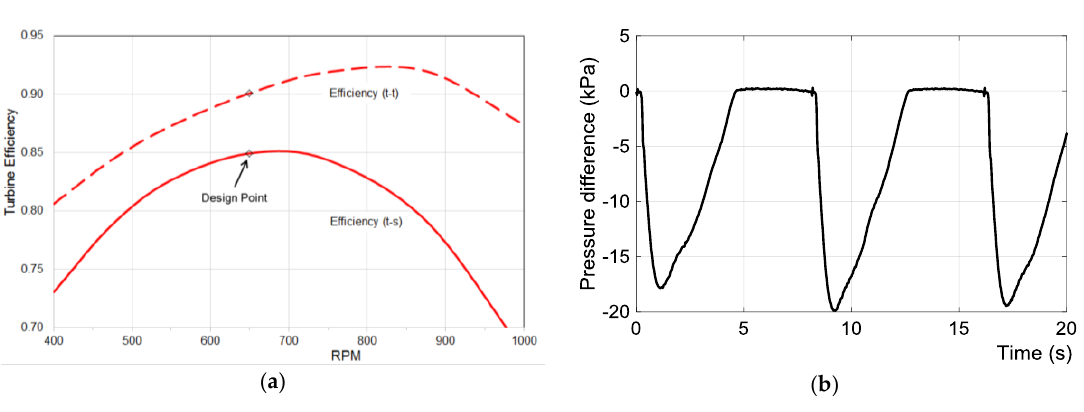
Figure 3. ( a ) Predicted efficiency curve for the unidirectional air turbine designed for OWC project, extracted from the turbine design report by PerAero Turbine Designs [8]; ( b ) Pressure drop vs time at 650 rpm [8].